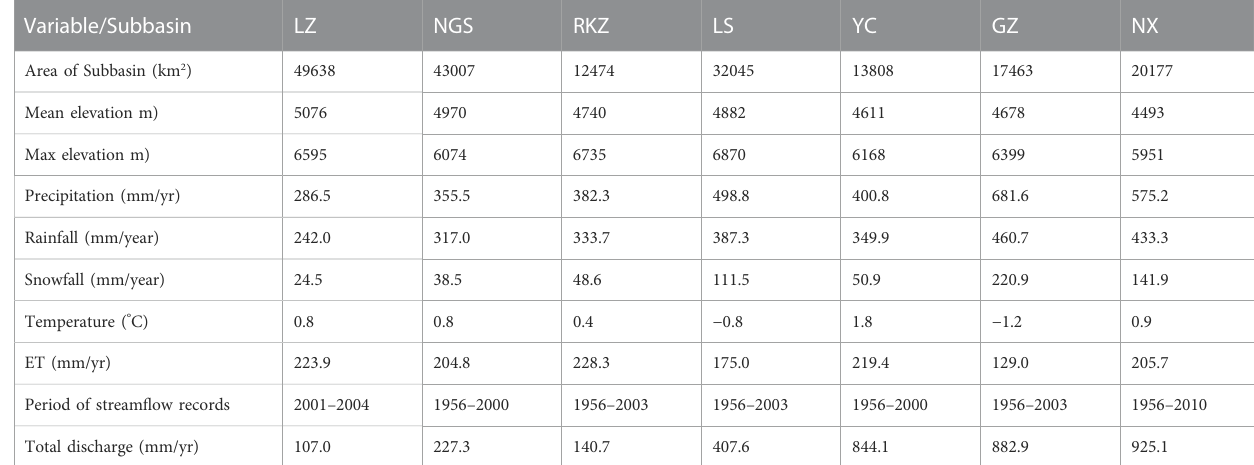
TABLE 2 Summary of drainage subbasins of